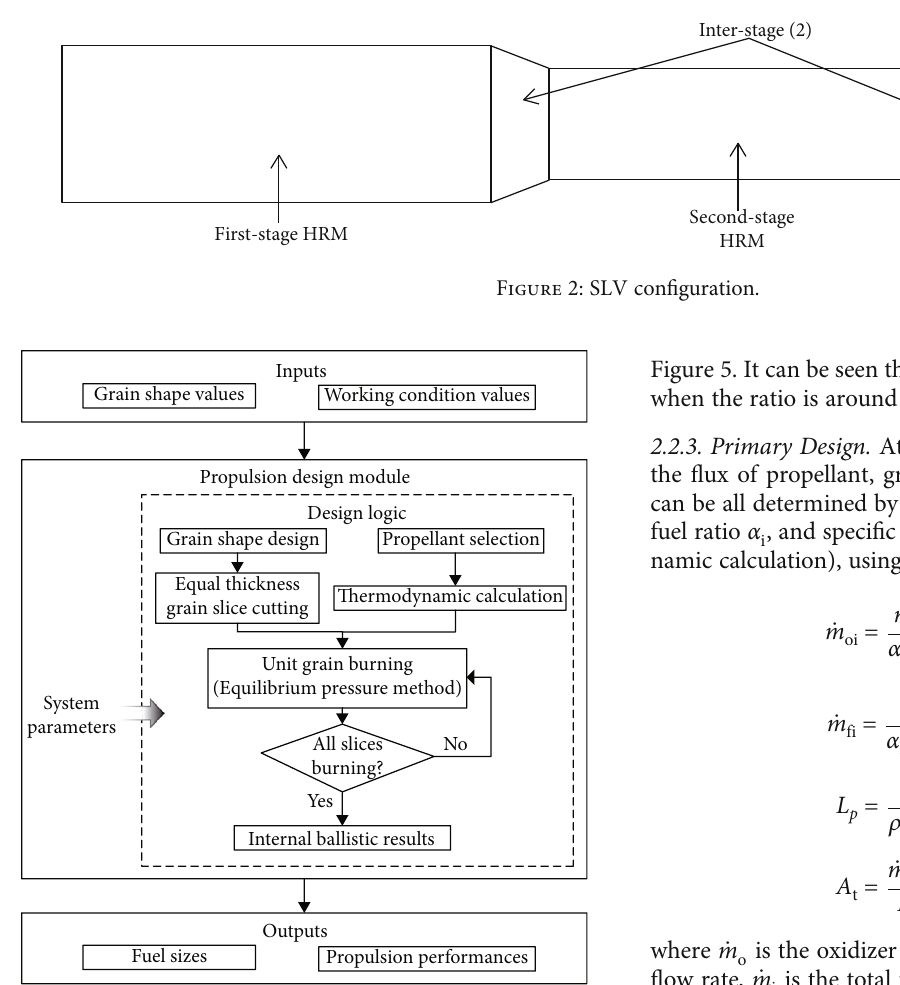
Figure 3: Framework of the propulsion system design